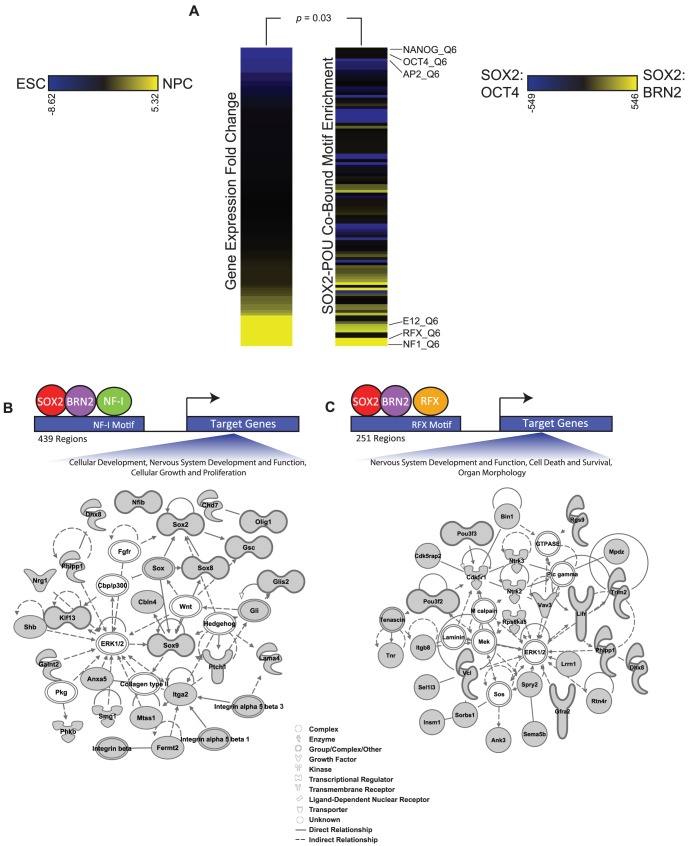
Additional transcription factor motifs are enriched in SOX2-POU-bound regions.(A) Heatmaps display the relationship between expression changes in transcription factors and the enrichment of their motifs in SOX2-BRN2 bound regions compared to SOX2-OCT4-bound regions. The full set of TRANSFAC motifs were ranked by statistical significance of enrichment in SOX2-BRN2-bound regions and in SOX2-OCT4-bound regions using the Mann-Whitney Wilcoxon test. The heat map on the right displays the change in rank of 108 TRANSFAC motifs between the two datasets. Only motifs that were ranked in the top 200 in either dataset are shown. The heat map on the left shows the fold change in gene expression between ESCs and NPCs of a transcription factor that recognizes the corresponding motif on the right. Scale bars: Left, fold gene expression change of transcription factors between ESCs (blue) and NPCs (yellow); Right, change in rank of TRANSFAC motifs between SOX2-OCT4 bound regions (blue) and SOX2-BRN2 bound regions (yellow). p-value reflects correlation of motif enrichment and gene expression of transcription factors which can recognize the motifs by a Monte-Carlo analysis. (B, C) Ingenuity Pathway Analysis to visualize the functional interconnection among genes associated with SOX2-BRN2 regions that also contain either an NF-I or RFX motif.